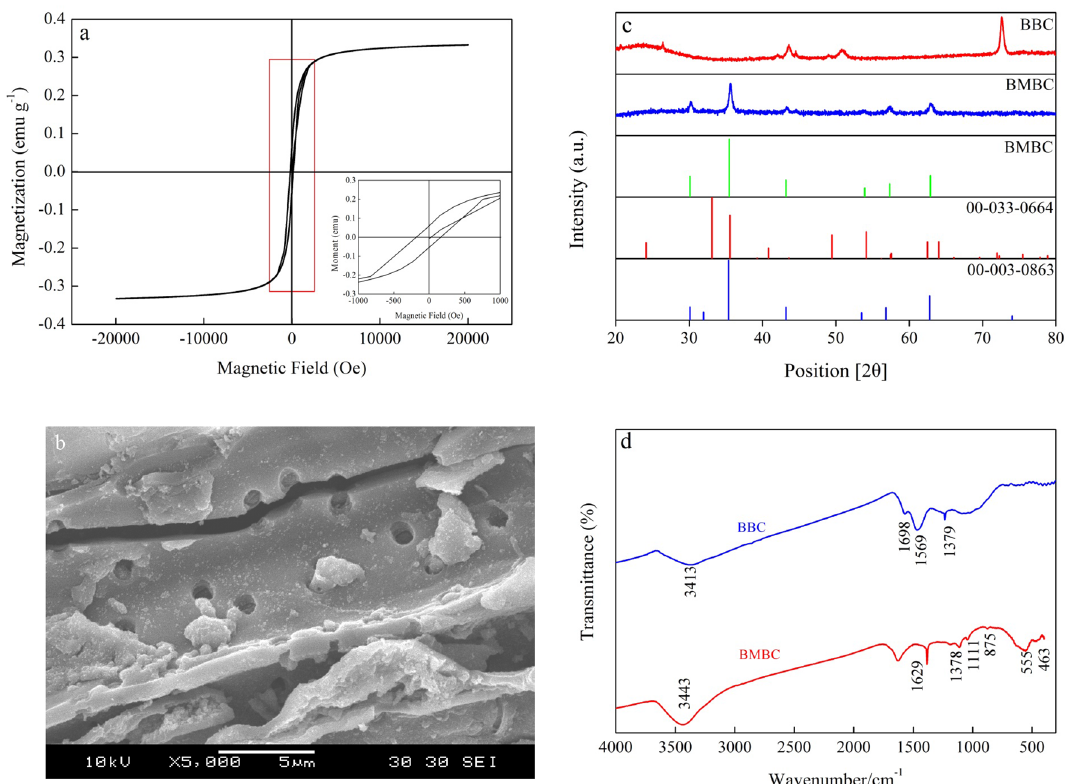
Figure 1. The magnetic hysteresis loops ( a ), SEM ( b ), XRD spectrum ( c ) and FT-IR spectrum ( d ) of